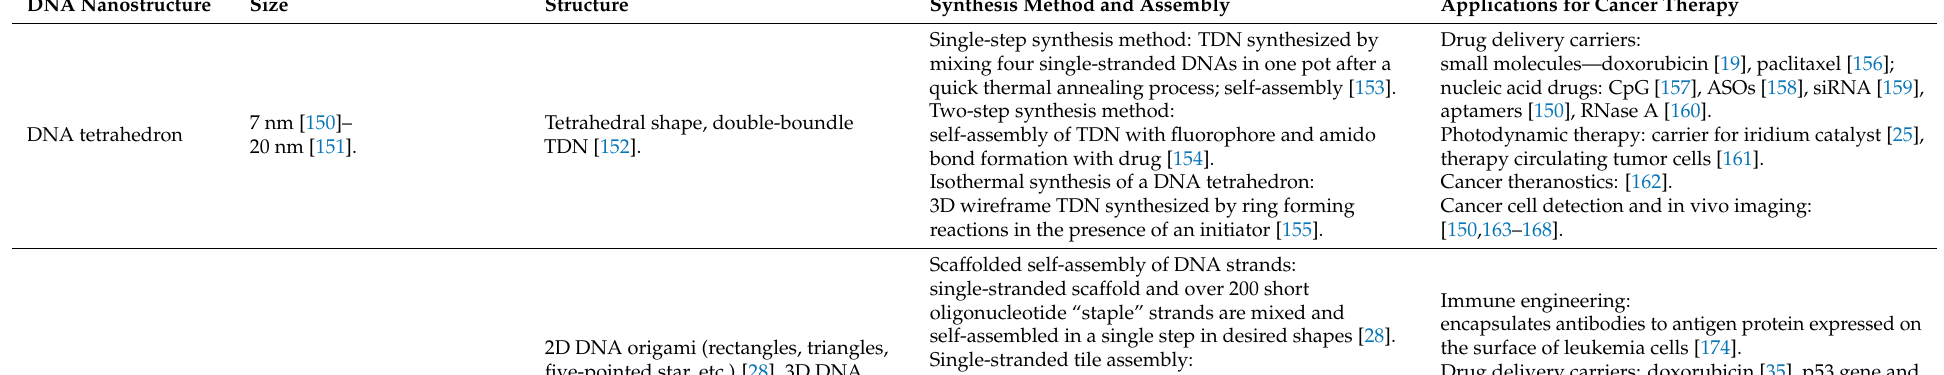
Table 1. Characteristics of DNA tetrahedrons, DNA origami, DNA nanotubes, and aptamers and their applications. DNA Nanostructure Size Structure Synthesis Method and Assembly Applications for Cancer